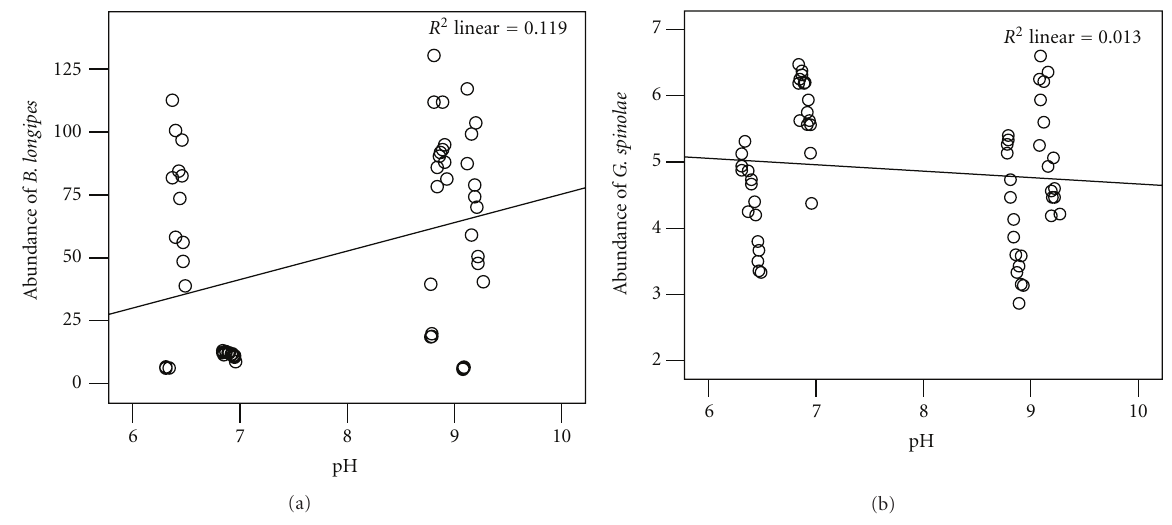
Figure 9: Relation between pH of water and abundance of (a) Brachydeutera longipes (Hendel) and (b) Gerris spinolae (Lethierry and Severin) as shown by regression